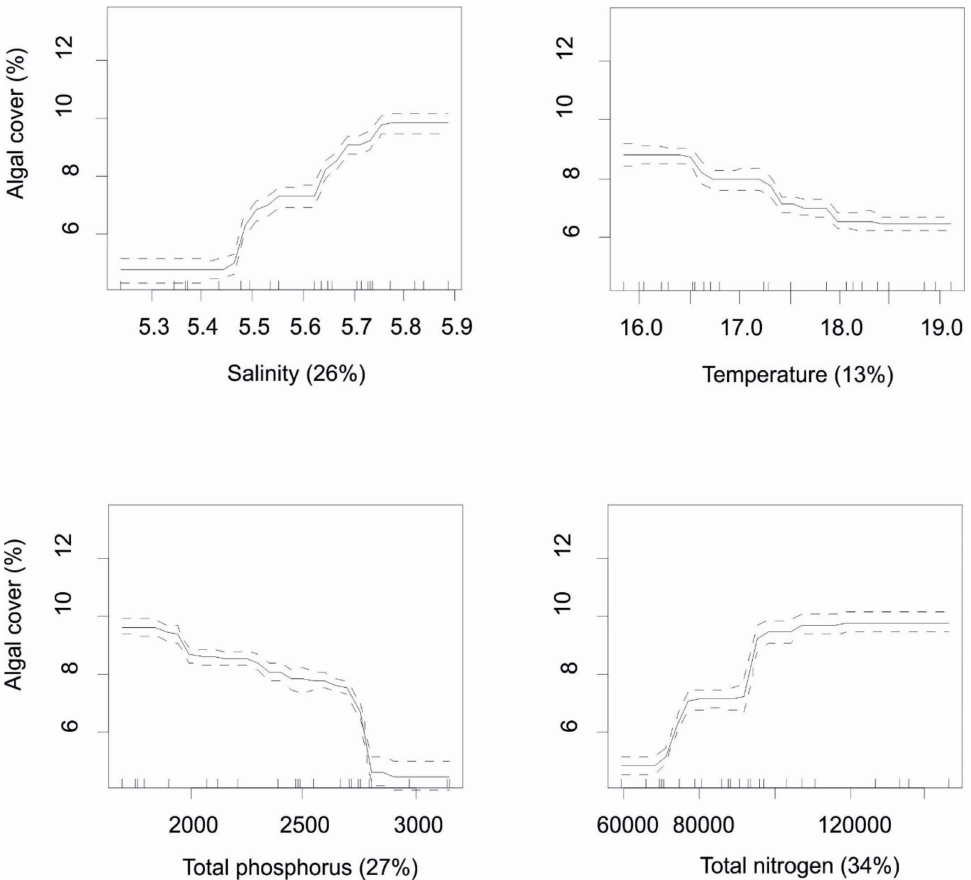
Figure 8. Partial dependence plots for boosted regression tree analyses relating the cover of macroalgae to the di ff erent environmental variables in Small Strait. The figure shows the e ff ect of an individual variable on the response when all other predictors are held at their mean values: positive fitted function values suggest that the cover of macroalgae responds positively, and negative values suggest the opposite. The relative importance of each variable is shown in parentheses on the x-axis. Solid lines depict shapes of the response between environmental variables and the cover of macroalgae (the fitted function without a smoother), and dashed lines represent standard error values of partial dependence curves. Each tick mark at the bottom of each graph represents the 10th percentile of the